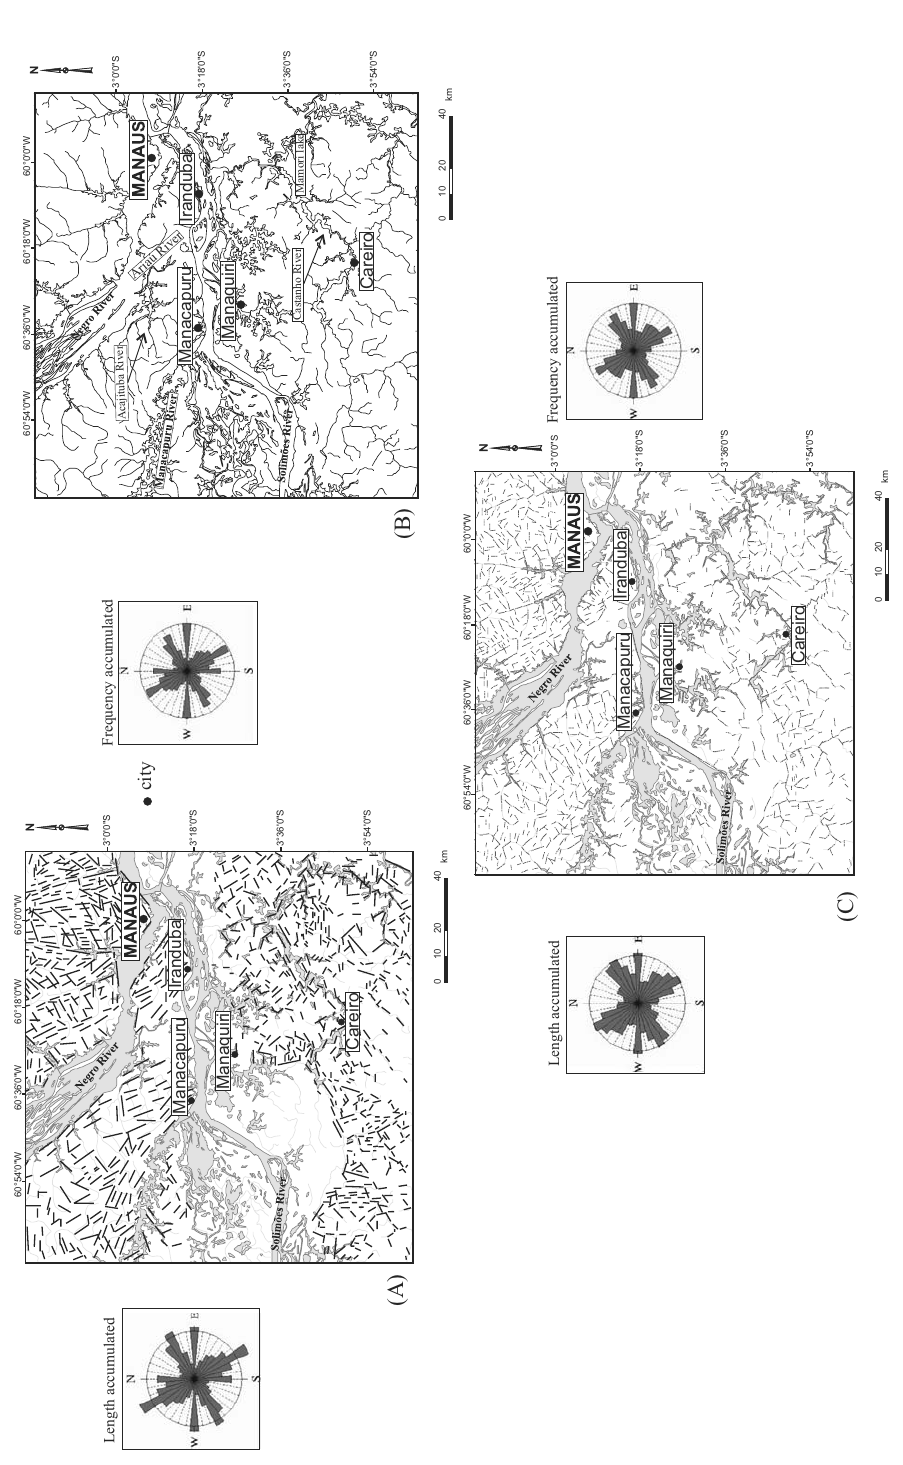
Fig. 6 – (A) Relief lineament map obtained from the analysis on Landsat ETM + image with rose diagrams (accumulated frequency and length). (B) Drainage lineament map with rose diagram.